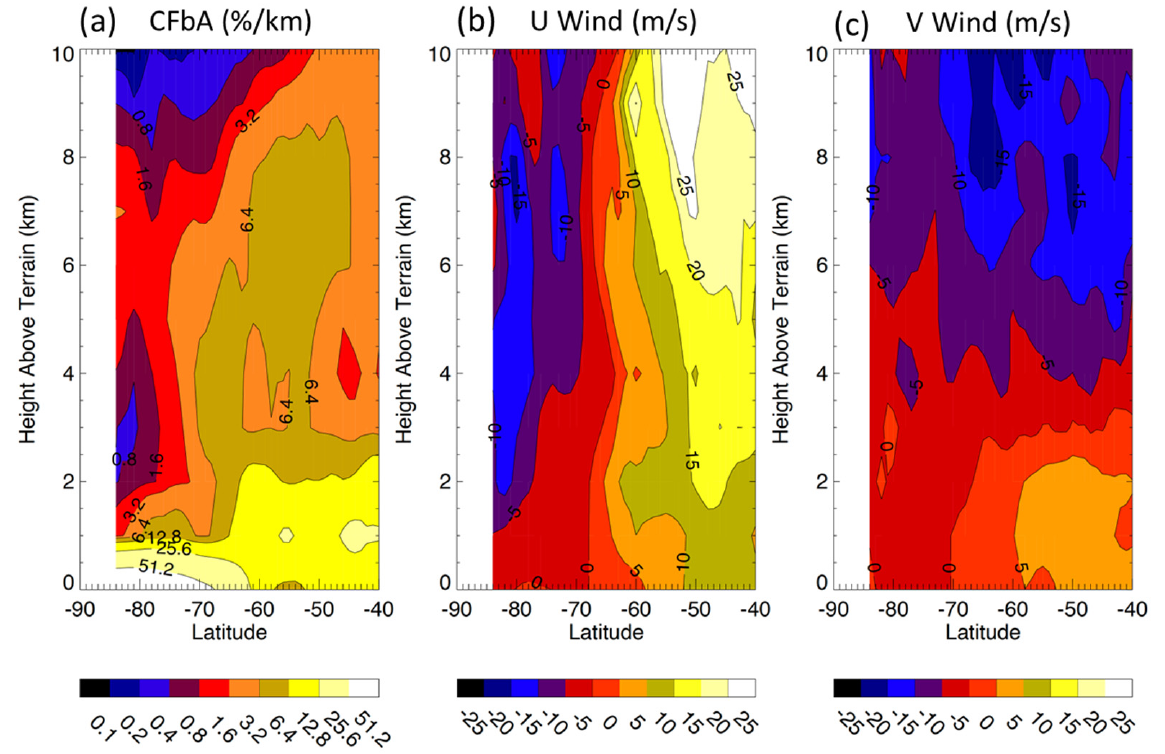
Figure 15. Vertical and latitudinal distributions of zonal mean ( a ) cloud occurrence frequency by altitude (CFbA) in %/km, ( b ) zonal wind (U), and ( c ) meridional wind (V) in m/s from 7 to 11 July 2021. The vertical coordinate is the stereo height above terrain, which is simultaneously derived with AMVs from cloud features in the IR band.